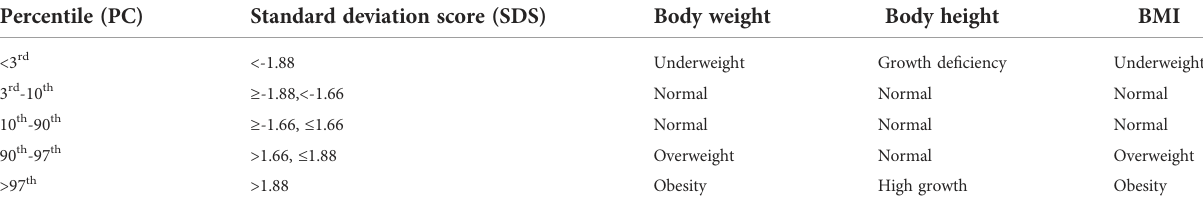
TABLE 5 Percentiles and corresponding values of the standard deviation score and their interpretation in relation to anthropometric